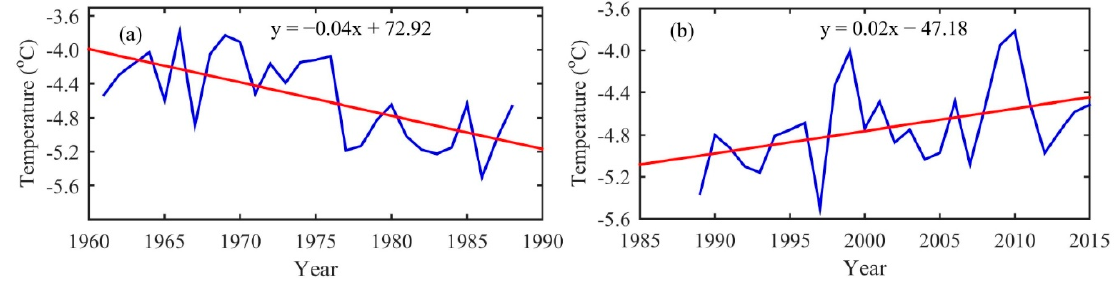
Figure 9. The temperature trend in the Everest region for the time period ( a ) 1961–1988 and ( b ) 1989–2015 using APHRODITE gridded dataset.